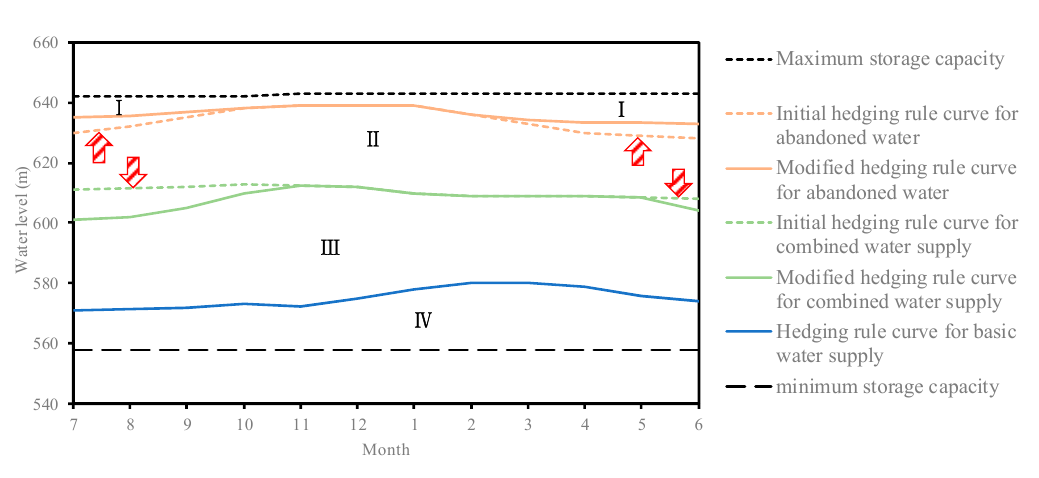
Figure 7. the monthly average change process of water abandoned of the Shiquan, Xihe, and Ankang reservoirs in condition of the Project optimized. The upper right part is the multi-year average change of abandoned water when the operation of Project is optimized or not.